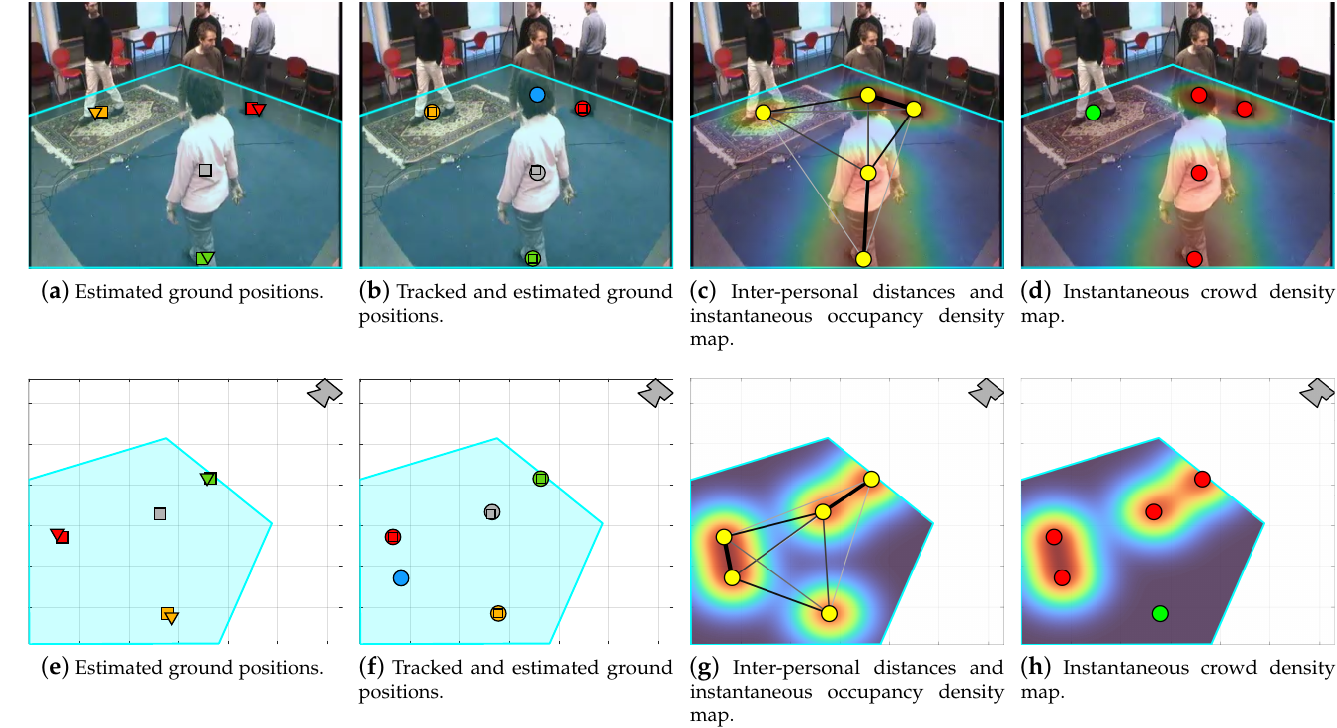
( e ) Estimated ground positions. ( f ) Tracked and estimated ground ( g ) Inter-personal distances and ( h ) Instantaneous crowd density positions. instantaneous occupancy density map. map. Figure 4. The proposed system outcome at each stage using the example input frame and the esti- mated poses in Figure 3. ( a – d ) demonstrate the localized human subjects, smoothed/tracked ground positions, inter-personal distances with the instantaneous occupancy map, and the instantaneous crowd map along with the detected social distance violations in the image–pixel coordinates, respec- tively. ( e – h ) present the same results as in ( a – d ), but in the real-world coordinates. The user-selected ROI is shown in cyan and covers the floor plane in the scene. The basic and proposed localization results are depicted by triangles and squares, respectively, while the smoothed/tracked ground positions are visualized with circles. The distances among the subjects are visualized using lines with varying thickness and darkness where thick/thin and dark/light lines indicate shorter/longer distances. The instantaneous occupancy and crowd density maps are computed with a 1 m spatial resolution ( δ = 1) and 2 m social safety distance ( r = 2), respectively. Note that the ground positions in ( a , b , e , f ) are color-coded in accordance with the estimated poses in Figure 3. The color notion is dropped in ( c , d , g , h ) to preserve privacy and to emphasize the recognition of a social distance infringement; red/green indicates the presence/absence of subjects violating the defined social safety